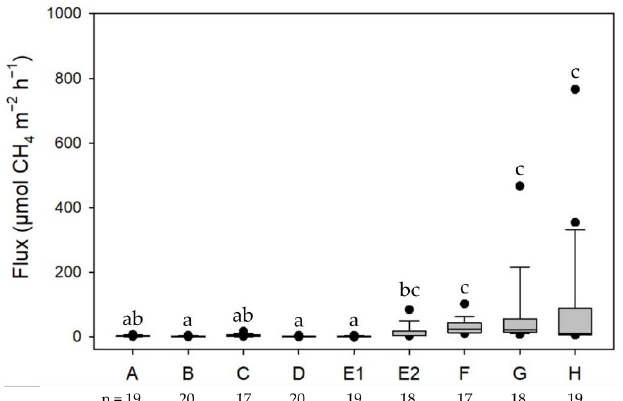
Figure 3. CH 4 emissions from the mangrove soils: A—Wazihwei (WZ); B—Zhuwei (ZW); C—Xinfeng (XF); D—Zhunan (ZN); E1—Fangyuan Kandelia obovata (FY-K); E2—Fangyuan Avicennia marina (FY-A); F—Budai (BD); G—Beimen (BM); H—Chiku (CK). The same letters over different bars suggest no significant differences among sites according to the Kruskal–Wallis test and Dunn’s test.